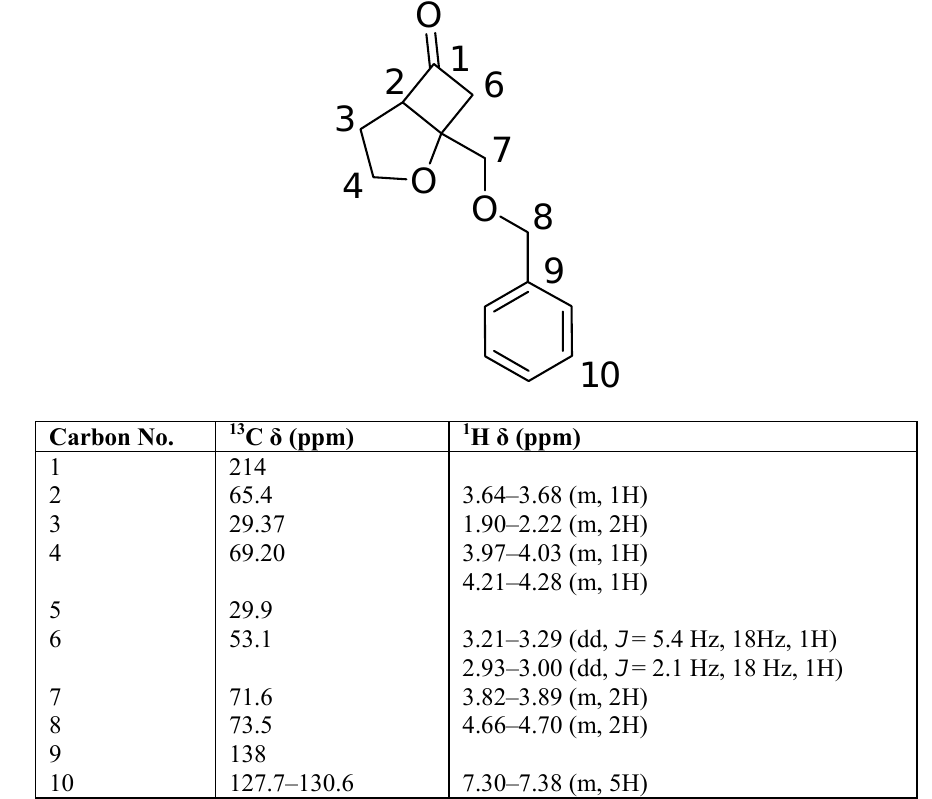
Table 1. Assignment of 13 C and 1 H Chemical Shift Values from COSY, HSQC and NOESY